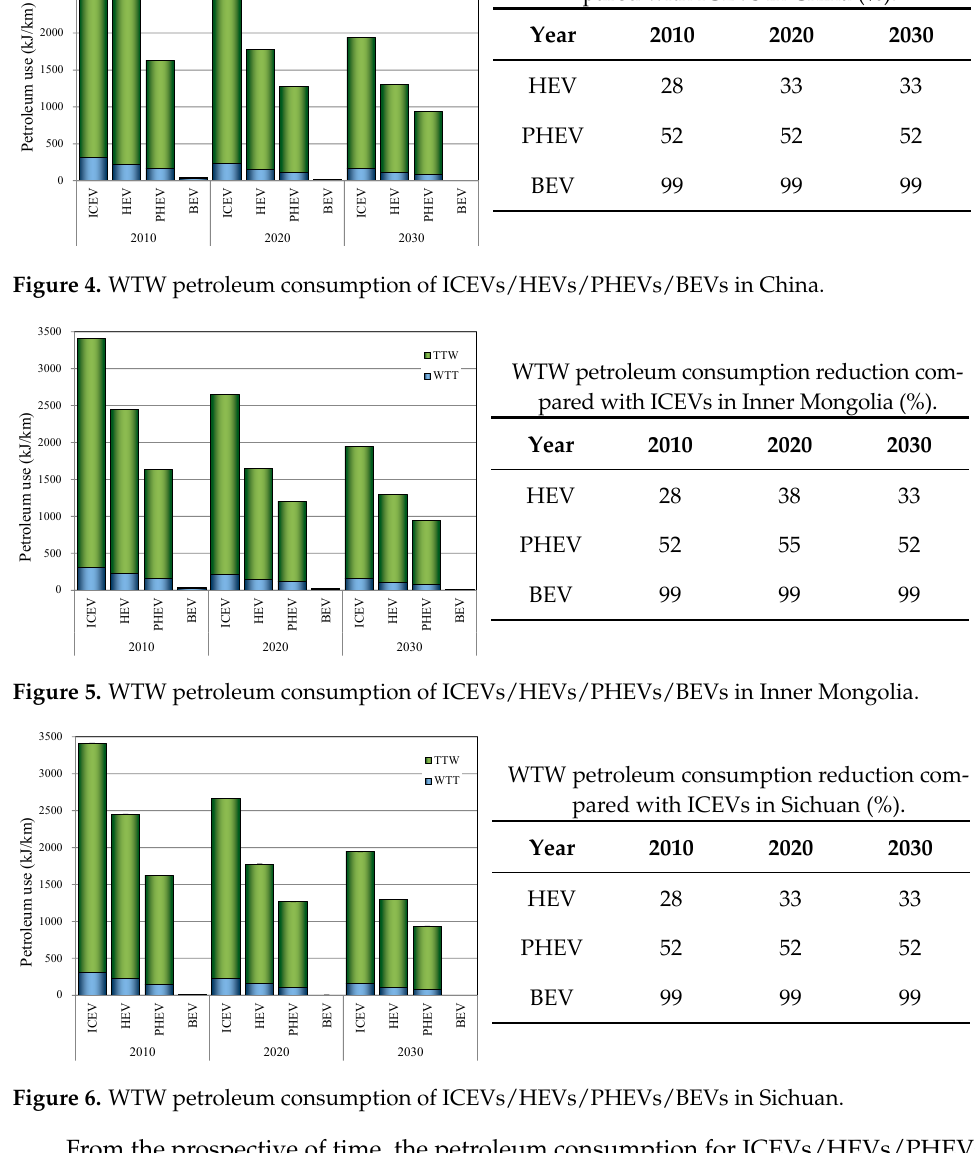
pared with ICEVs in China (%).